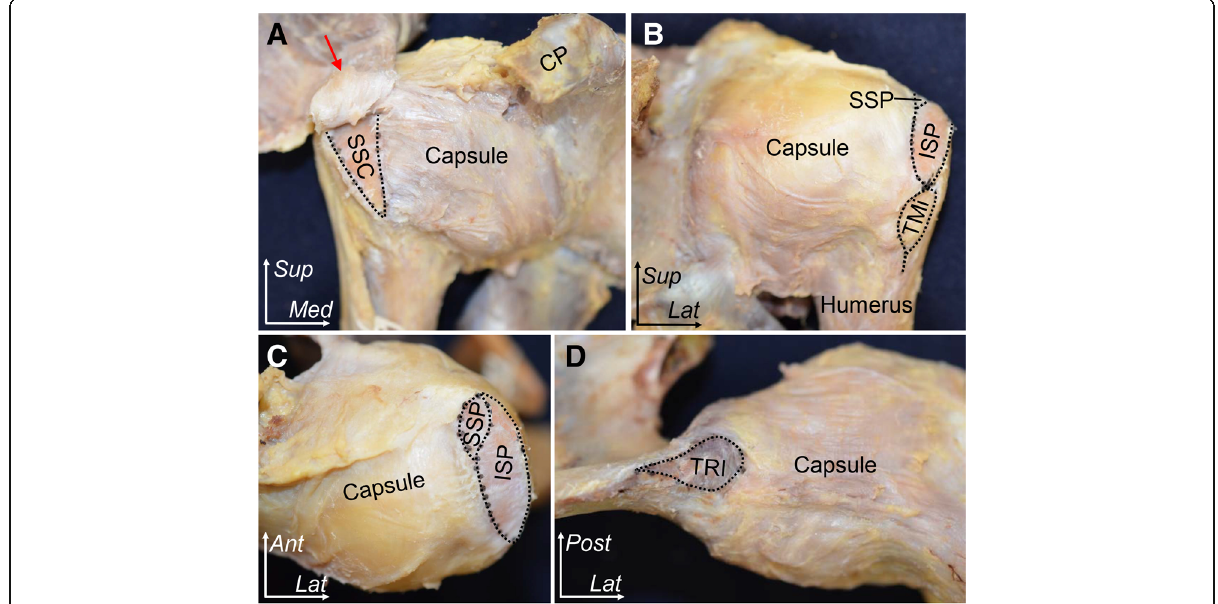
Fig. 2 Outward appearance of the shoulder joint. Areas outlined by black dotted lines indicate insertions of the subscapularis (SSC), supraspinatus (SSP), infraspinatus (ISP), teres minor (TMi), and the origin of long head of triceps brachii (TRI). a Anterior aspect of the shoulder. The superior- most part of the subscapularis was left intact because it was tightly connected to the capsule and the coracohumeral ligament (red arrow). b Posterior aspect. c Superior aspect. d Inferior aspect. CP, coracoid process; SS, scapula spine; TRI, triceps; Ant , anterior; Med , medial; Lat , lateral; Sup , superior; Post , posterior